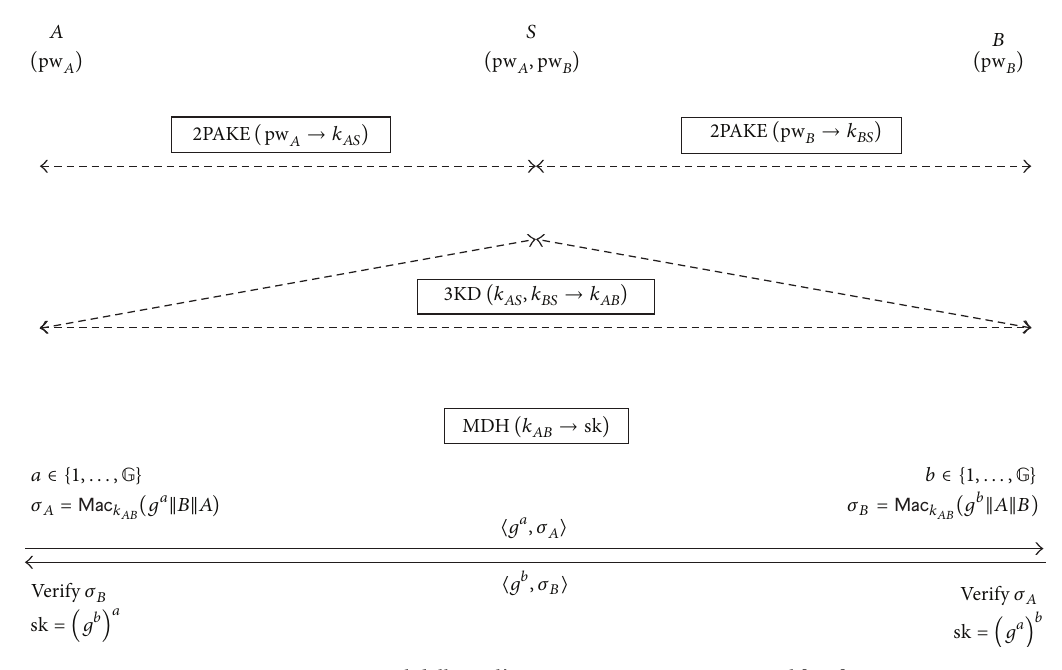
Figure 1: GPAKE: Abdalla et al.’s generic 3-party PAKE protocol [8,